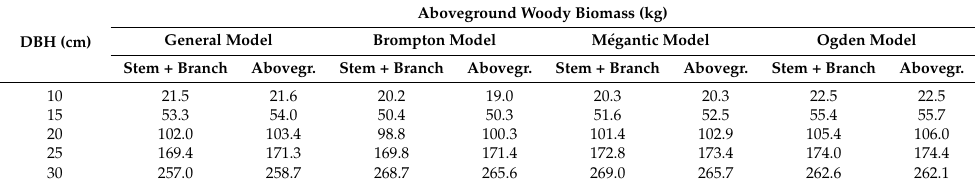
Table 8. Predicted values for aboveground woody biomass of trees with different DBH using the sum of predicted values from the stem biomass and branch biomass models (Stem + Branch) or using the predicted value from the aboveground woody biomass models (Abovegr.). Predicted values using the general and the site-specific models are